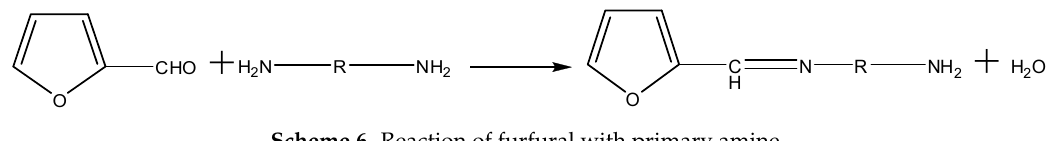
Scheme 6. Reaction of furfural with primary amine.